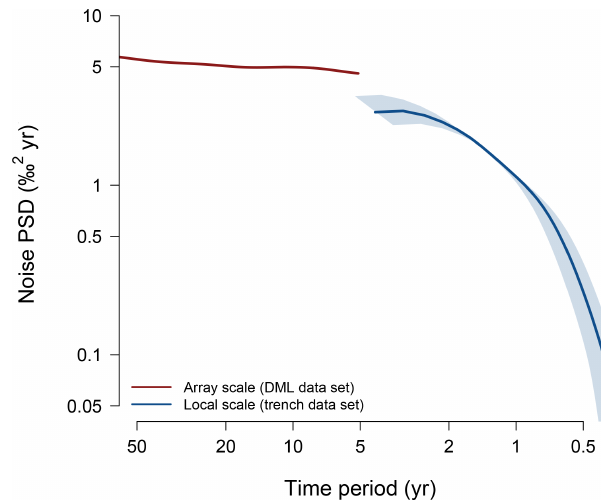
Figure 5. Comparison of DML noise spectra as a function of in- tersite distance. The red curve (array scale, ∼ 100km) shows the section for periods ≤ 50 years of the composite noise spectrum from the DML1 and DML2 firn-core records (Fig. 2b and text). The blue curve (local scale, ∼ 100m) depicts the noise spectrum esti- mated from 22 shallow ( ∼ 3 . 5m depth) trench profiles from EDML (Münch et al., 2017a, b). The depth scale of the trench data has been converted into time units using a constant accumulation rate of 25cm of snow per year, neglecting the small compression by densification (Münch et al., 2017a). Blue shading denotes the spec- tral range from an assumed 20% uncertainty of the accumulation rate. Note that the trench noise spectrum is not corrected for the diffusional smoothing, which has a negligible effect on the trench records for the 5-year period and thus does not affect the compari- son of the noise